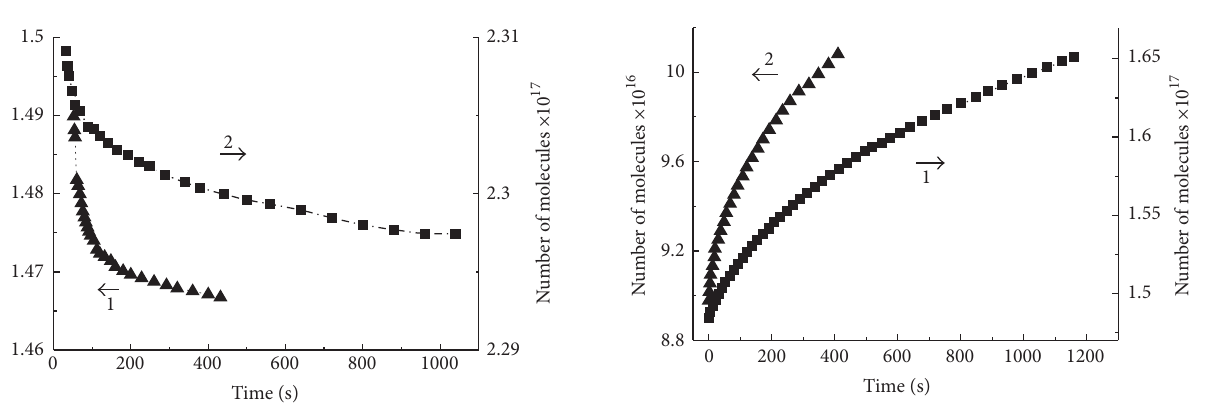
F 2: Kinetics of Freon 134a (1) and Freon 22 (2) adsorption on a powder-like sample produced from a TiO